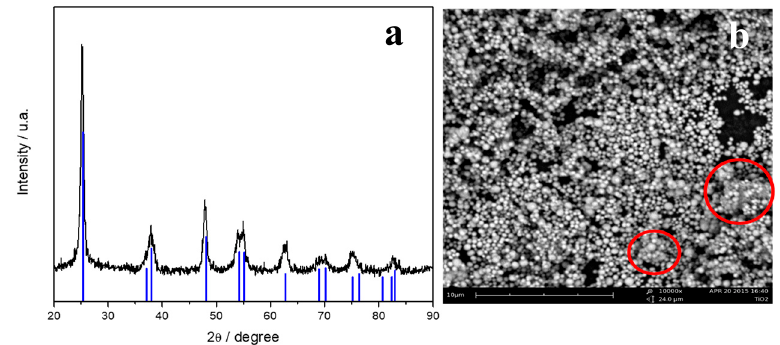
Figure 1. X-ray di ff raction pattern ( a ) and SEM image ( b ) of TiO 2 -SO 4 Figure 1. X-ray diffraction pattern ( a ) and SEM image ( b ) of TiO 2 -SO 4 powder .